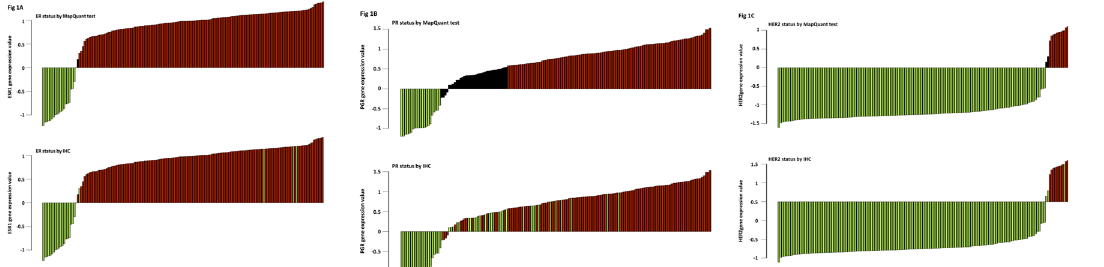
Fig 1. A: Estrogen-Receptor status (ER). Comparison between the Immunohistochemistry analysis (IHC) and the MapQuant test. Top. ER status determined by IHC referred to MapQuant test. Green: IHC-negative tumours. Red: IHC-positive tumours. Vertical axis: MapQuant test values. 4 IHC-negative cases were positive with the MapQuant test. Bottom. MapQuant determination of the ER status. Green: negative. Black: equivocal. Red: positive. Both equivocal cases corresponded to IHC-positive tumours. B: Progesterone-Receptor status (PR): comparison between the Immunohistochemistry analysis (IHC) and the MapQuant test. Top. PR status determined by IHC referred to MapQuant test. Green: IHC-negative tumours. Red: IHC-positive tumours. Vertical axis: MapQuant test values. 11 IHC-negative cases were positive with the MapQuant test. Bottom. Determination of the PR status by the MapQuant test. Green: negative. Black: equivocal. Red: positive. Equivocal cases corresponded to 15 IHC- positive tumours and 20 IHC-negative tumours. C: HER2 status. Correlation between the Immunohistochemistry analysis (IHC) and the MapQuant test. Top. HER2 status determined by IHC referred to MapQuant test. Green: IHC-negative tumours. Red: IHC-positive tumours. Vertical axis: MapQuant test values. Only one IHC-negative case was found positive with the MapQuant test. Bottom. Determination of the HER2 status by the MapQuant test. Green: negative. Black: equivocal. Red: positive. Equivocal cases corresponded to 2 IHC-negative tumours.